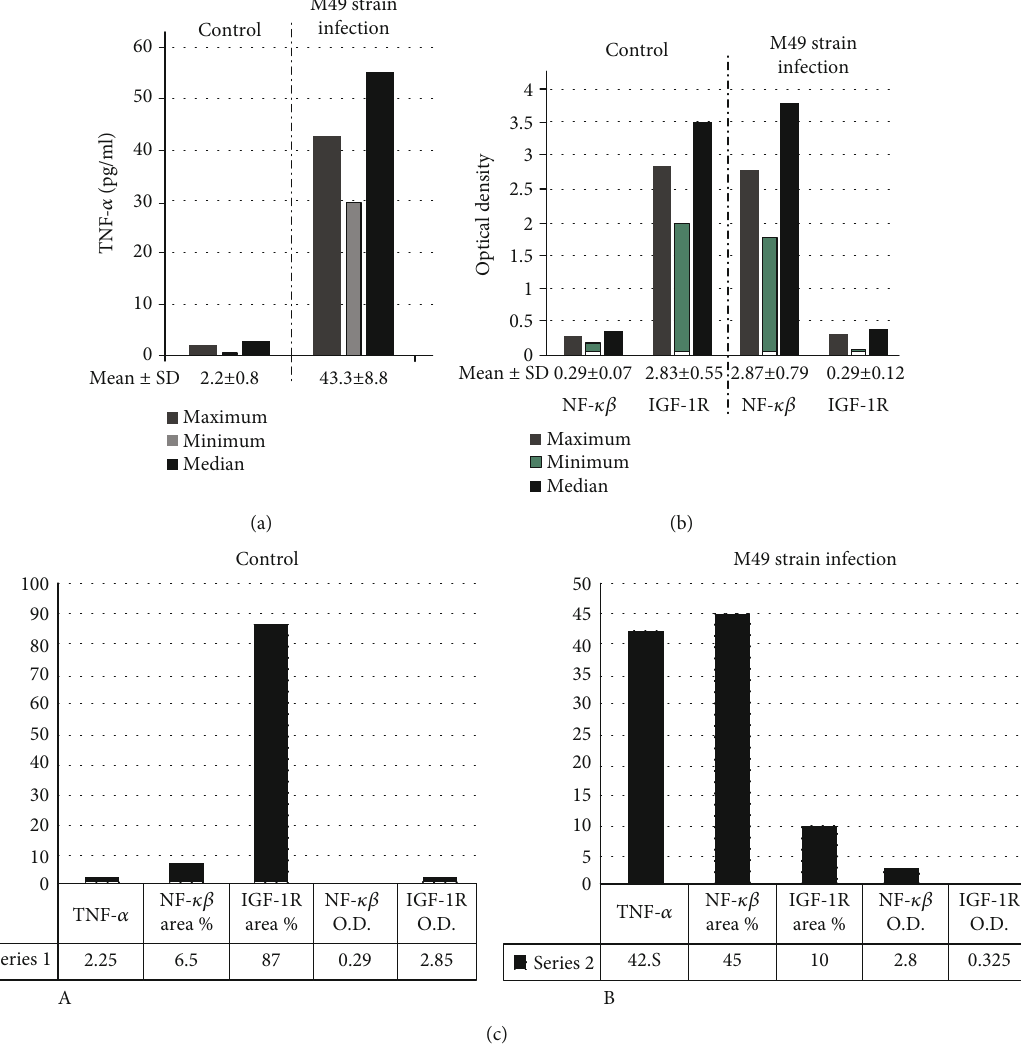
Figure 4: In the form of median, maximum, minimum, and median values, the bar charts in (a) and (b) show a simple descriptive statistical analysis of di ff erent biomarkers on the 12 th week post infection from the six chronically infected mice and healthy controls. (a) TNF- α (pg/ml) measured in the serum. (b) NF- κβ and IGF-1R intracerebral densitometry. (c) Using the mean values, the collaborative data of the biomarkers in the serum and the cerebral tissue microenvironment were shown involving TNF- α in pg/ml and NF- κβ and IGF-1R, area %, and